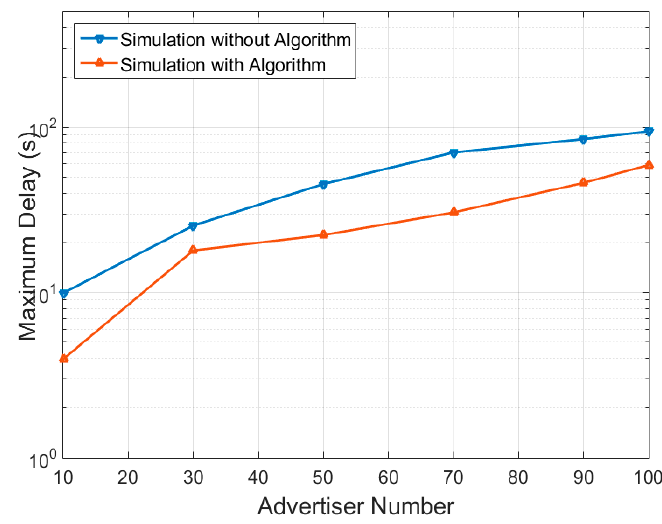
Figure 12. Maximum delay of one advertiser discovery by the scanner in the worst case scenario.